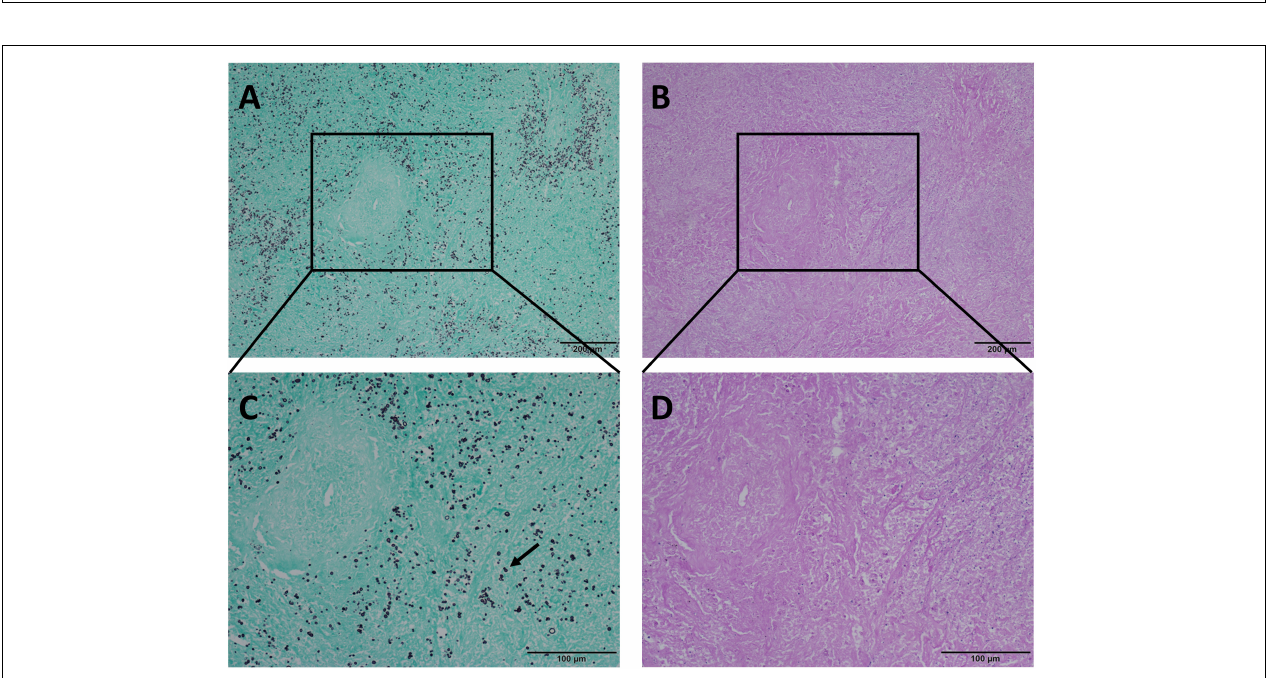
FIGURE 5 | Comparison of GMS and PAS staining in the same view of pulmonary necrotic tissues with pulmonary cryptococcosis. (A,C) Cryptococcus spores are clearly visible at low and medium-power magnification, and the morphological characteristics of narrow-based budding (arrow) are clear with GMS staining at medium-power magnification. (B) With PAS staining, the necrotic area is purplish-red, and Cryptococcus is not visible at low-power magnification. (D) PAS staining shows the necrotic area as purplish-red color, and Cryptococcus is not easily distinguished at medium-power magnification. GMS, Grocott methenamine silver; PAS, periodic acid-Schiff. (Original magnifications: A,B , × 100; C,D , × 200).